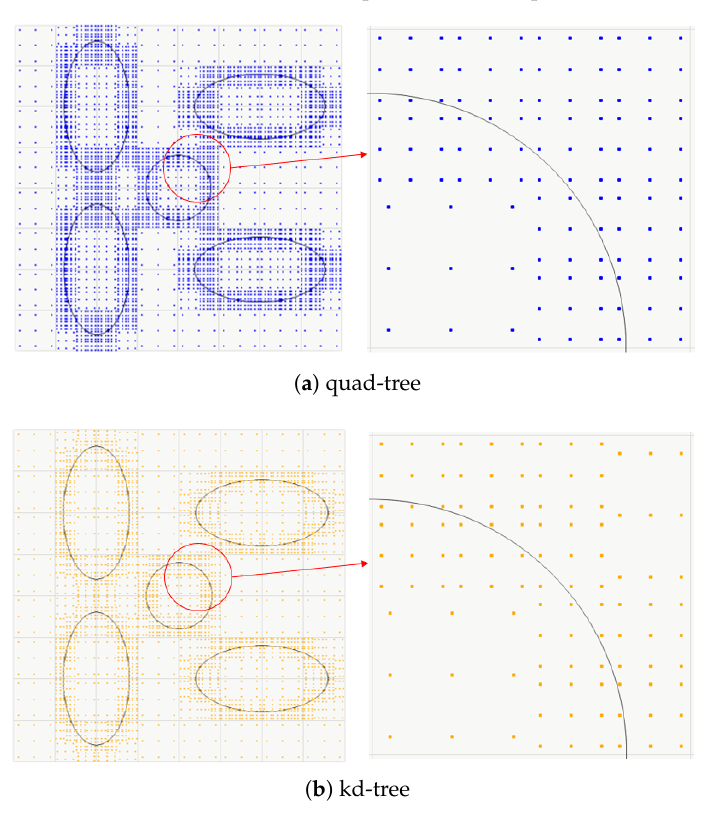
Figure 25. Quadrature points generated for the example in Figure 24a using ( a ) quad-tree and ( b ) kd-tree data structure with two